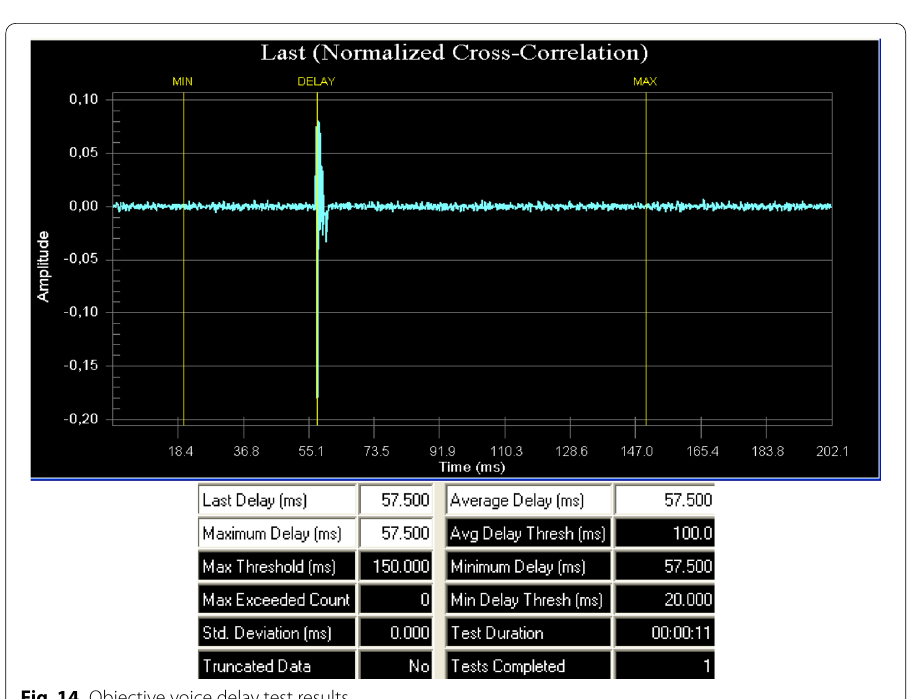
Fig. 14 Objective voice delay test